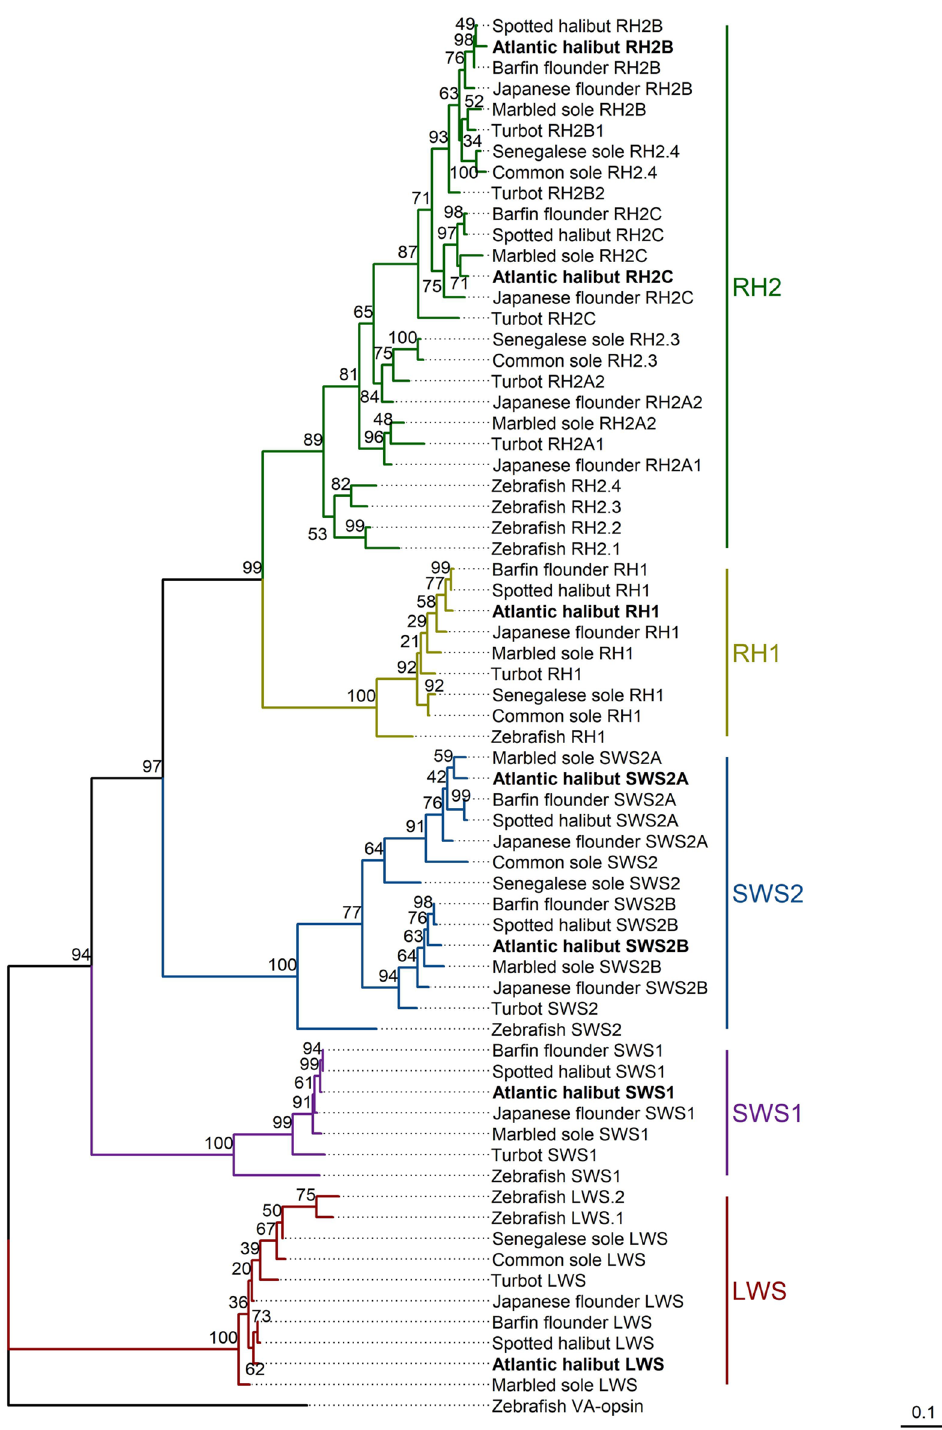
Figure 14. Maximum likelihood tree of flatfish and zebrafish amino acid sequences for five opsin classes: SWS1, SWS2, RH1, RH2, and LWS. Bootstrap values ( n = 100) are located next to the branches and predicted opsins for Atlantic halibut are bolded. See Supplementary Table S11 for accession numbers